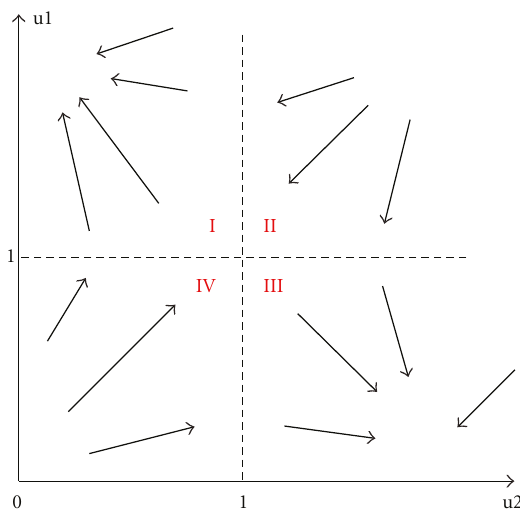
Figure 4: Illustration of the dynamics in the 2 × 2 Q